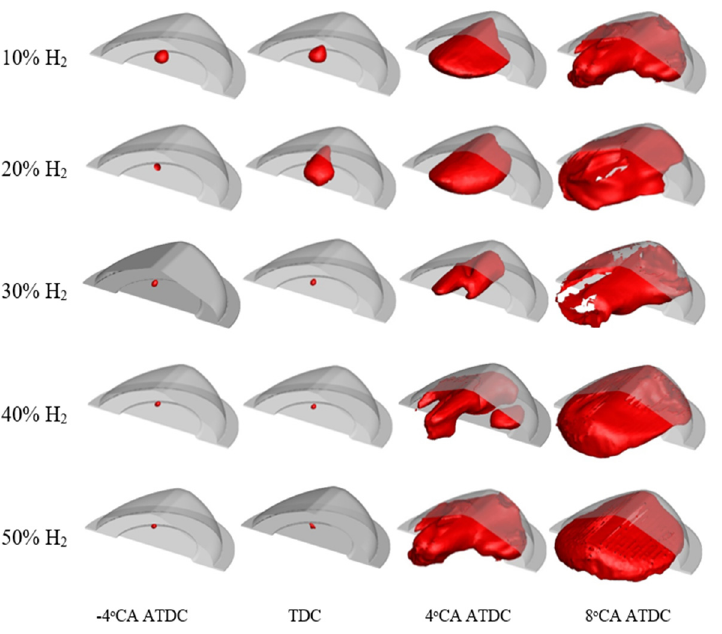
Figure 5. Flame propagation contours for different HES. Reproduced with permission from Aghahasani, M., etc., Energy Convers Manag.; published by Elsevier, 2022 [43].